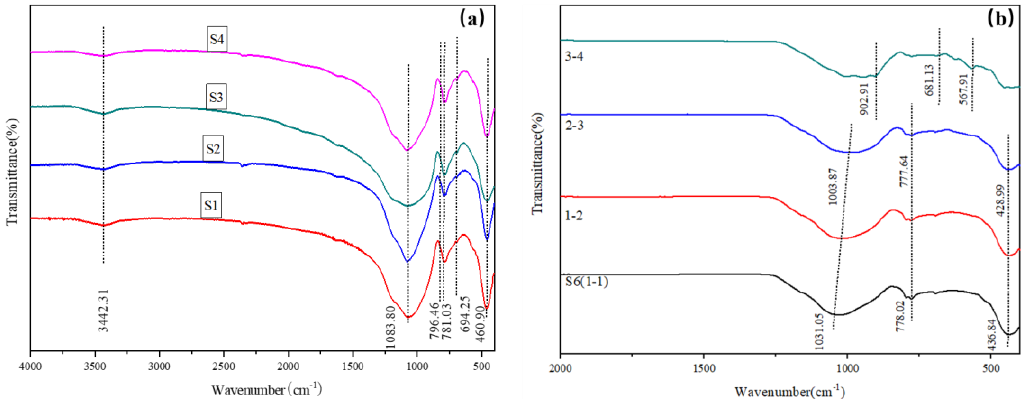
Figure 11. ( a ) Infrared spectra of the foam ceramics and ( b ) microcrystalline foam ceramics.